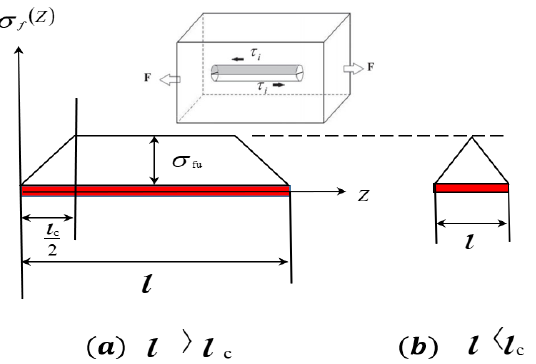
Figure 11. Stress as a function of the length/aspect ratio of TiB fibers ( a ) above the critical value and ( b ) below the critical value. ( b ) below the critical